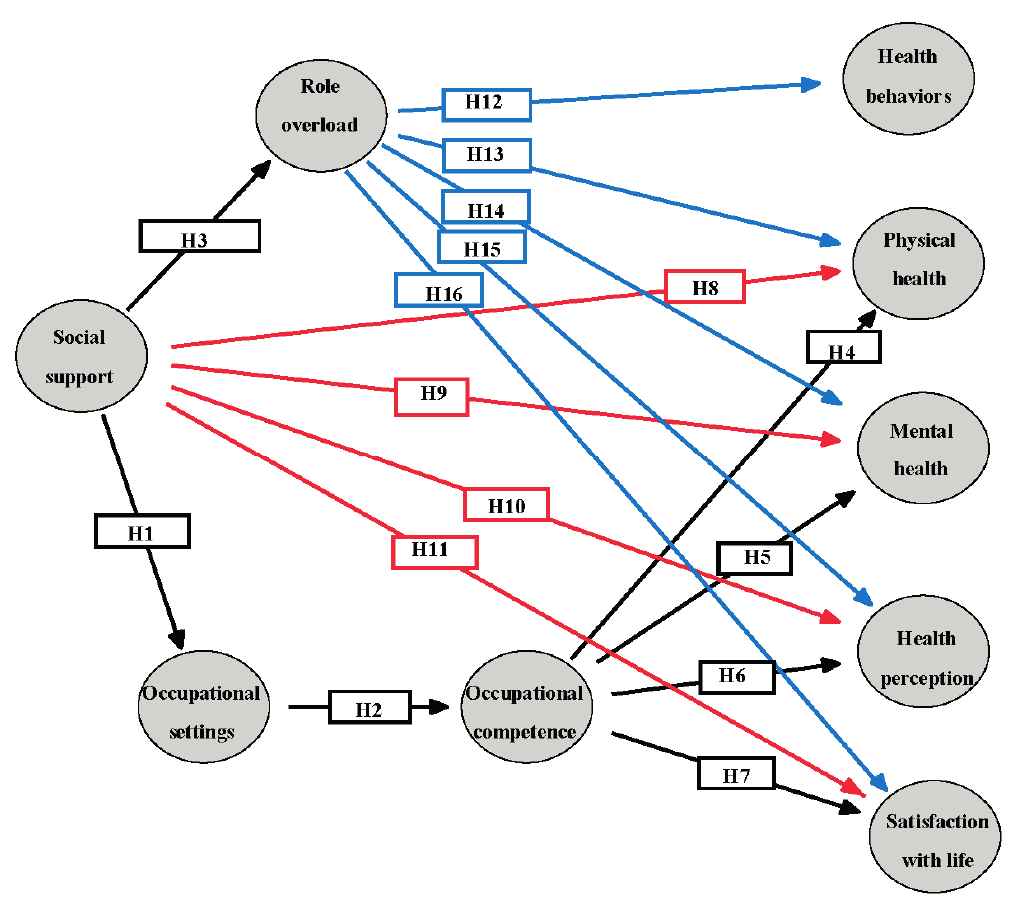
Figure 1. Three alternative theoretical models to describe mothers’ health and life